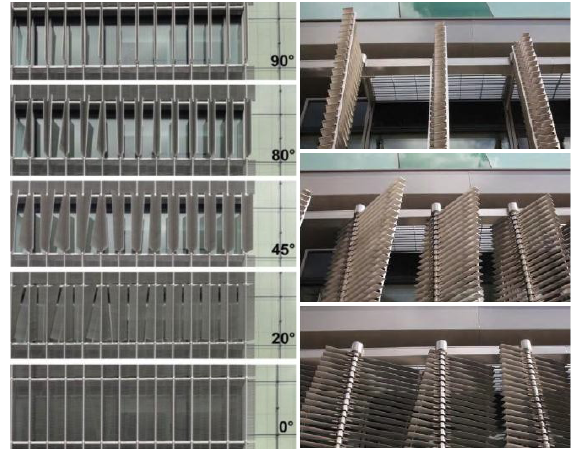
Figure 9. Photo of the south and east facades of the Q1 Building